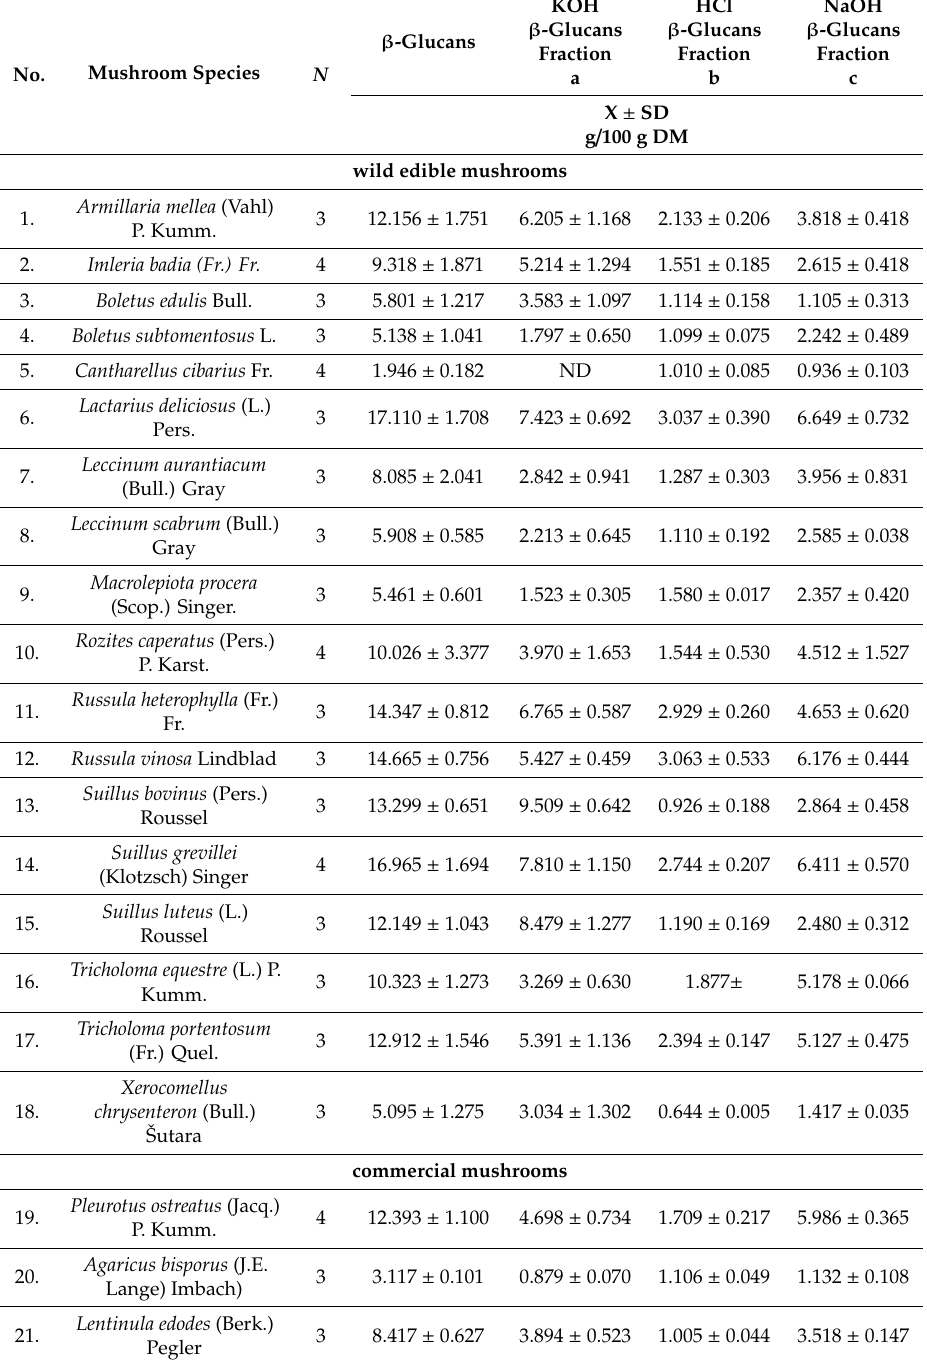
Table 2. The Congo red positive β -glucans in the studied wild and commercial mushrooms in di ff erent